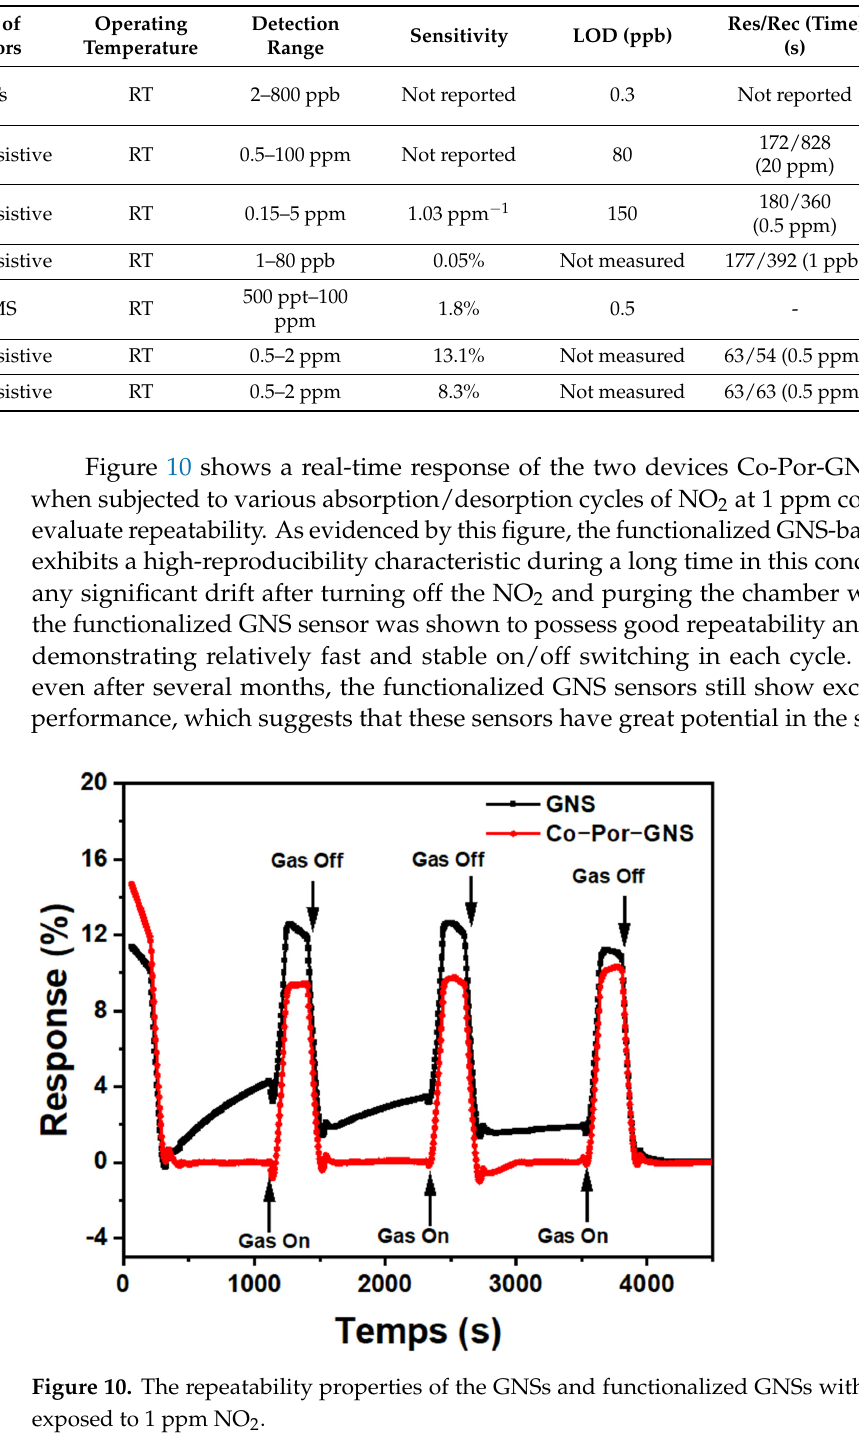
Table 2. Sensing properties comparison with literature.